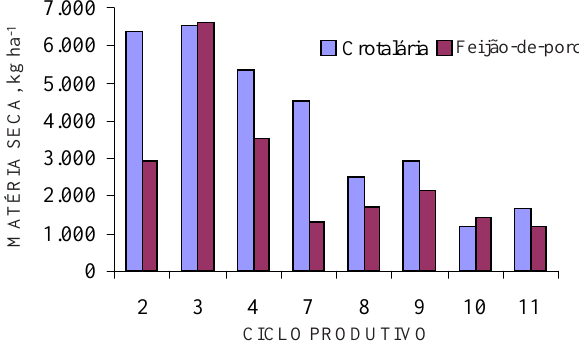
Figura 1. Produção de matéria seca das leguminosas em oito dos onze ciclos ocorridos no consórcio com videira no Submédio São